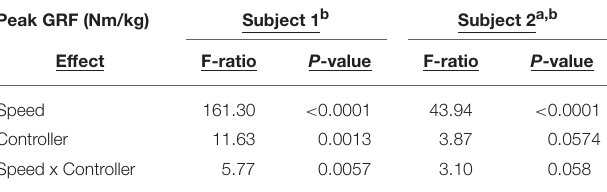
TABLE 2 | Vertical ground reaction force for two